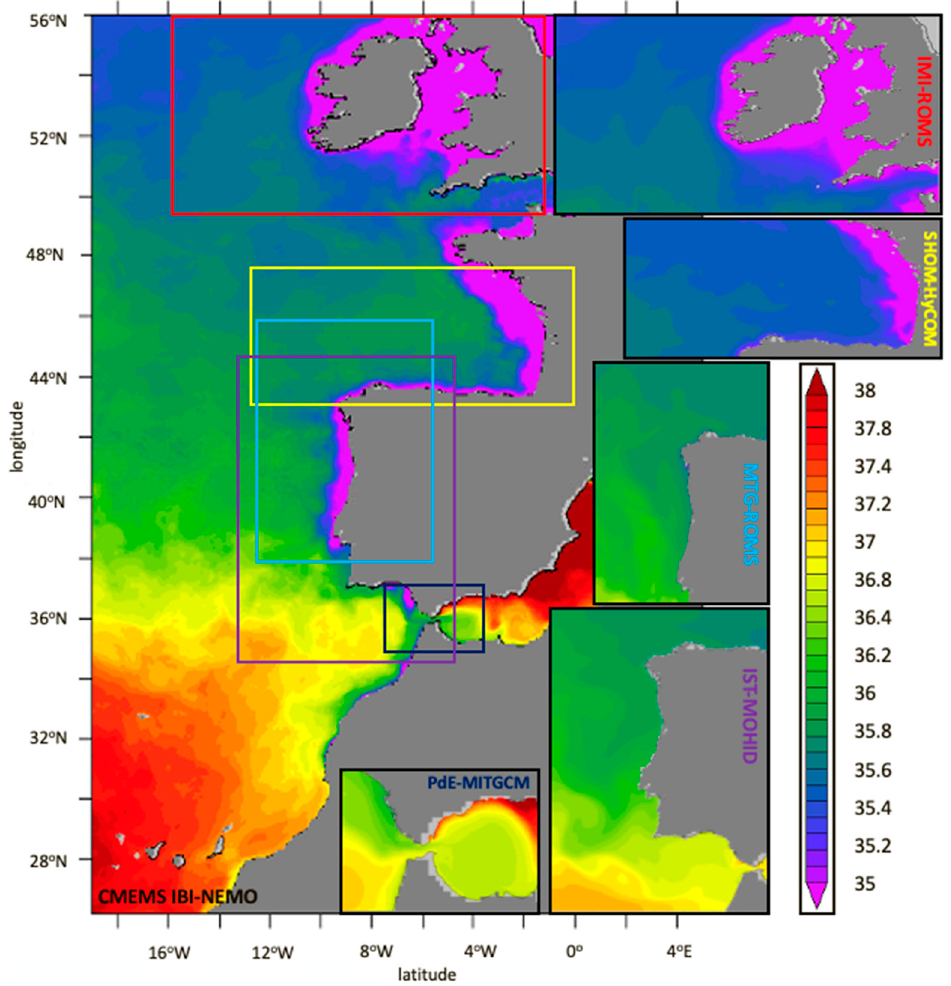
Figure 1. 2018 Spring (March-April-May) Sea Surface Salinity (SSS) field (psu) simulated by different operational ocean models in the IBI region. The following ocean model solutions, included in the MyCoast Multi-Model Exercise, are shown (each application based on a different model and covering a different geographical domain): The CMEMS IBI regional solution, based on NEMO model and covering the whole IBI region (CMEMS-IBI-NEMO), the Puertos del Estado model (PdE-MITGCM) I for the Strait of Gibraltar (dark blue), the Instituto Superior Tecnico de Lisboa (IST-MOHID) system for the western Iberian domain (purple), the MeteoGalicia (MTG-ROMS) forecast service for the Northwestern Iberian domain (cyan), the Irish Marine Institute (IMI-ROMS) application for Ireland (red), the Service hydrographique et océanographique de la Marine application (SHOM-HyCOM) for the Gulf of Biscay (yellow).